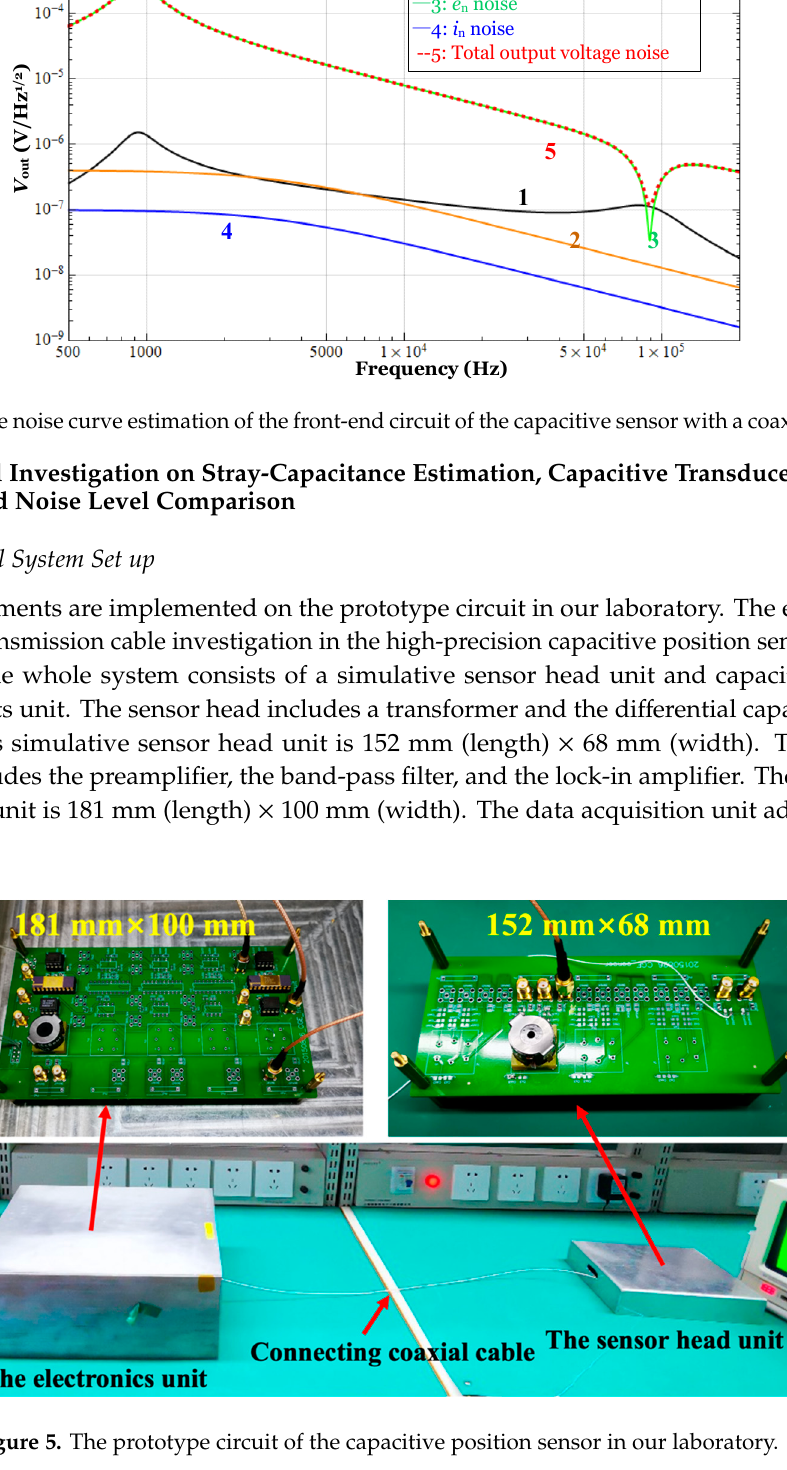
Figure 5. The prototype circuit of the capacitive position sensor in our laboratory.